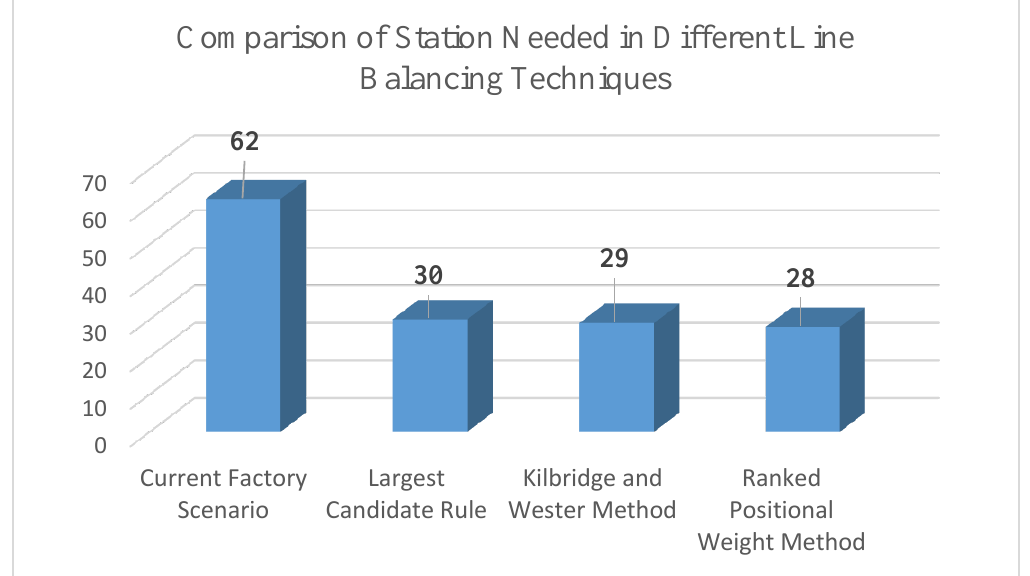
Figure 10. Comparison of station needed in different line balancing techniques.